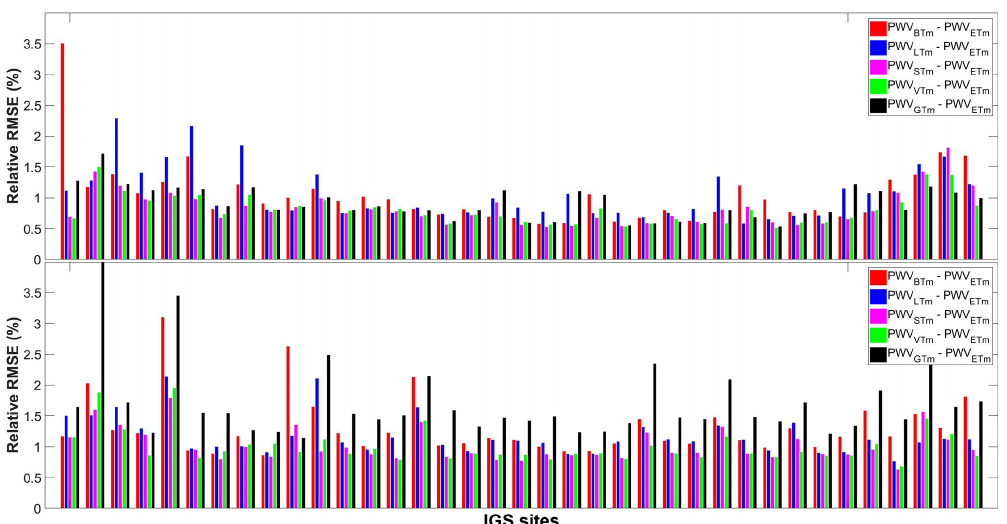
Figure 11. Relative RMSEs of PWV BTm , PWV STm , PWV VTm and PWV GTm compared with PWV ETm at 74 IGS stations in the year 2016.